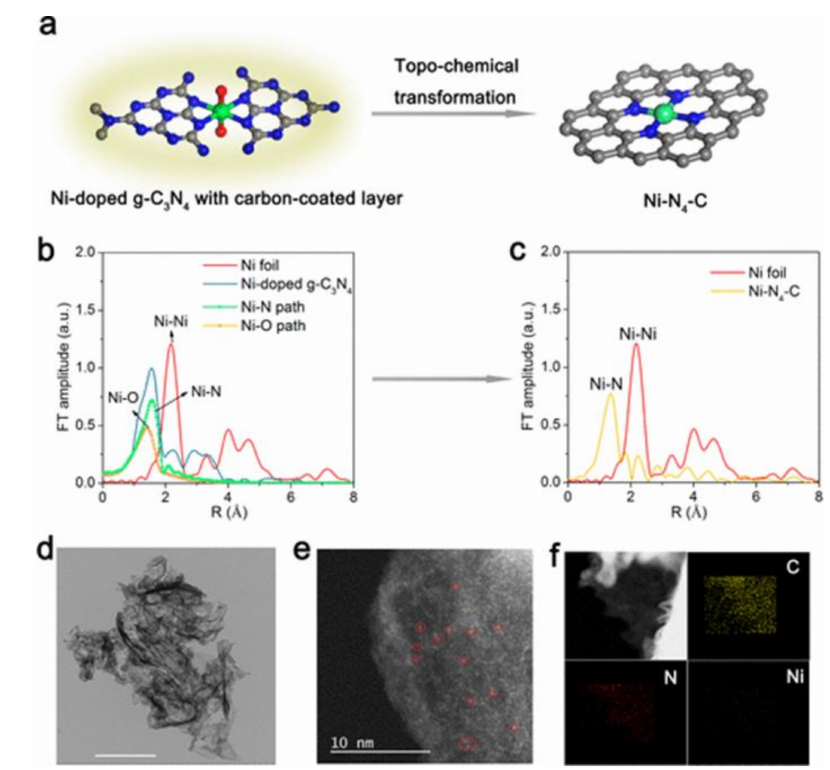
Figure 5. Ni–N 4 as effective active sites for the CO 2 RR to CO. ( a ) Scheme of the synthesis of the Ni–N 4 –C catalyst (Ni atoms in green; N atoms in blue; C atoms in gray; O atoms in red); ( b ) Fourier transform of the Ni K-edge EXAFS oscillations of Ni-doped g-C 3 N 4 with carbon-coated layer; ( c ) Fourier transform of the Ni K-edge EXAFS oscillations of the Ni–N 4 –C catalyst; ( d ) TEM image of the Ni–N 4 –C catalyst (scale bar: 500 nm); ( e ) HAADF-STEM result for of the Ni–N 4 –C catalyst; ( f ) Element mapping images of the Ni–N 4 –C catalyst. Reprinted with permission from Ref. [55]. Copyright 2022 American Chemical Society.